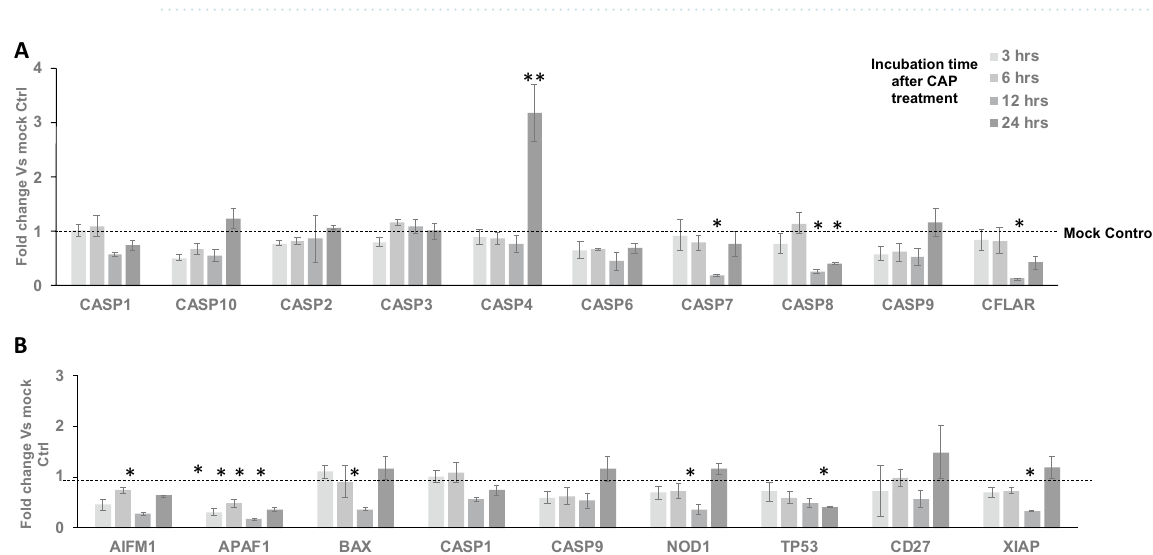
Figure 2. CHCP treatment differentially regulates the apoptosis regulation genes. Bar graph showing the differential gene expression of genes involved in the positive ( A ) and negative ( B ) regulation of apoptosis after CAP treatment in TNBC cell line MDA-MB-231. The samples were normalized to 18s rRNA and the fold change were compared to mock controls. Error bars represent means ± SEM. Student t test significant at *p values < 0.05, **p values < 0.01.